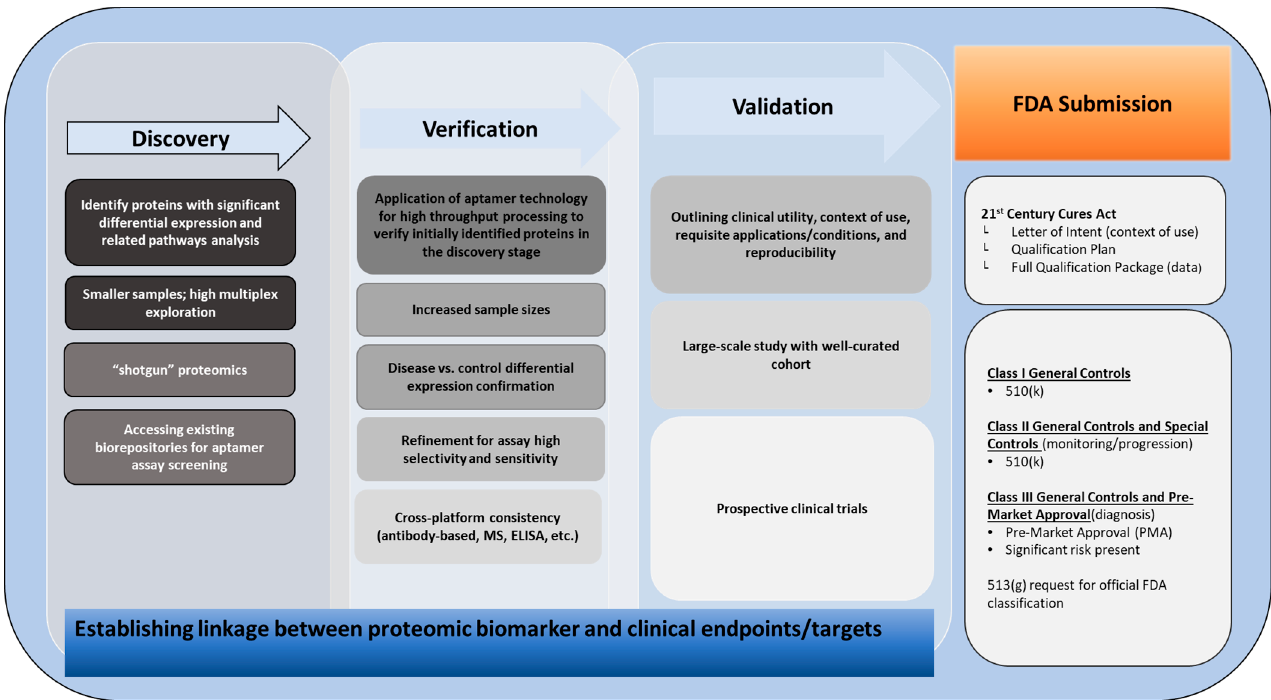
Figure 2. Process map advancing large-scale proteomic datasets from discovery to verification to validation towards identifying clinically meaningful biomarkers for FDA submission.